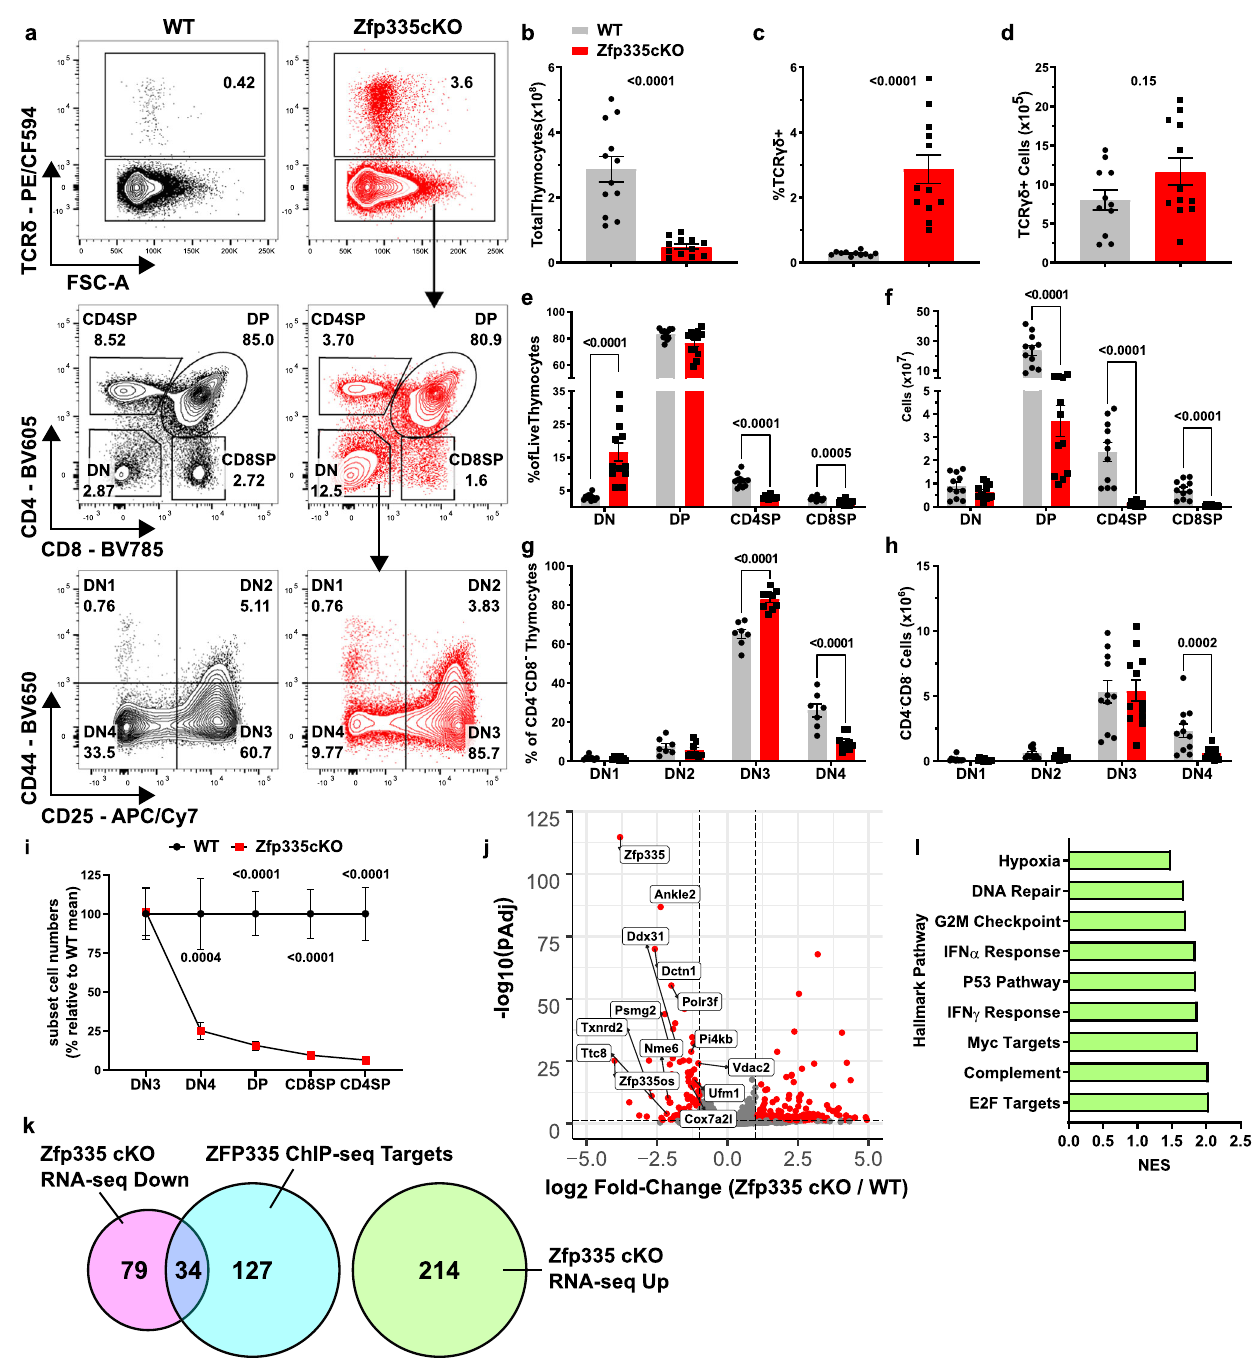
Fig. 1 | Zfp335 is critical to αβ T-cell development. a Gating schema for ex vivo analysis thymocyte development beginning with live thymocytes (DAPI − CD90.2 + , Fig S11a). b Total thymic cellularity in WT (Cre-negative) or Zfp335 fl / fl E8 III -cre (Zfp335cKO) mice. Total numbers ( c ) and frequency ( d ) of TCR γδ + cells in WT or Zfp335cKOthymuses.Numbers( e )andfrequencies( f )ofDN,DP,andSPthymocyte subsets in WT or Zfp335cKO thymi. Numbers ( g ) and frequencies ( h ) of early DN1- DN4 thymocyte subsets in WT or Zfp335cKO thymuses. i Relative cells numbers in DN3-SP thymocyte subsets represented as percent of WT mean. j Volcano plot of differentially expressed genes between Zfp335cKO and WT by RNA-seq. k Overlap between Zfp335 ChIP-seq (GSE58293) and differentially expressed genes in